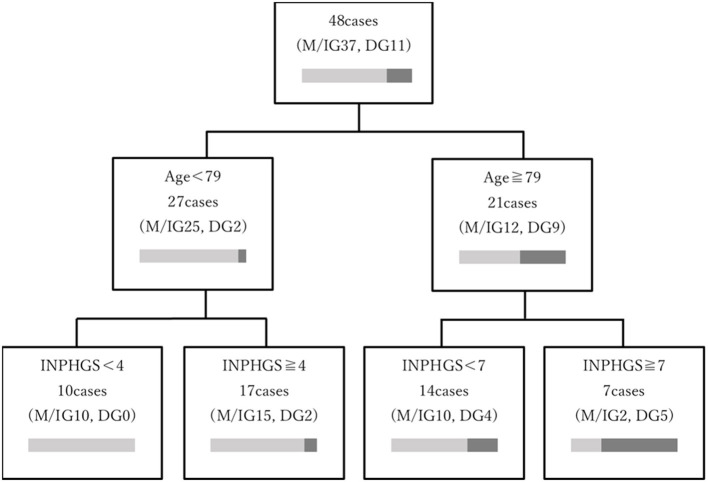
Decision tree model depicting the prognostic factors associated with long-term cognitive function after surgery for idiopathic normal pressure hydrocephalus. The decision tree was based on age and Idiopathic Normal Pressure Hydrocephalus Grading Scale (INPHGS) score as variables related to long-term cognitive function and ordered by the relative importance of each feature included in the model. The characteristics associated with the most favorable outcome (100% probability of maintenance/improvement) were age <79 years and INPHGS score <4 points. Furthermore, the combination of preoperative age ≥79 years with INPHGS score ≥7 showed the worst outcomes (29% probability of maintenance/improvement).